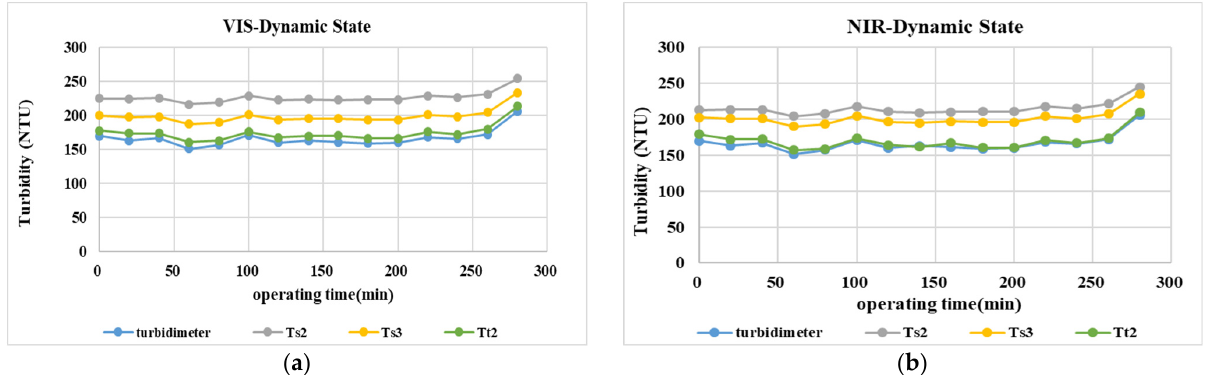
Figure 8. Continuing monitoring results for stream water turbidity verified by different lighting sources. ( a ) VIS measurement. ( b ) NIR measurement. sources. ( a ) VIS measurement. ( b ) NIR Table 9. Statistics of average error for continuing monitoring of stream water turbidity verified by different lighting sources.